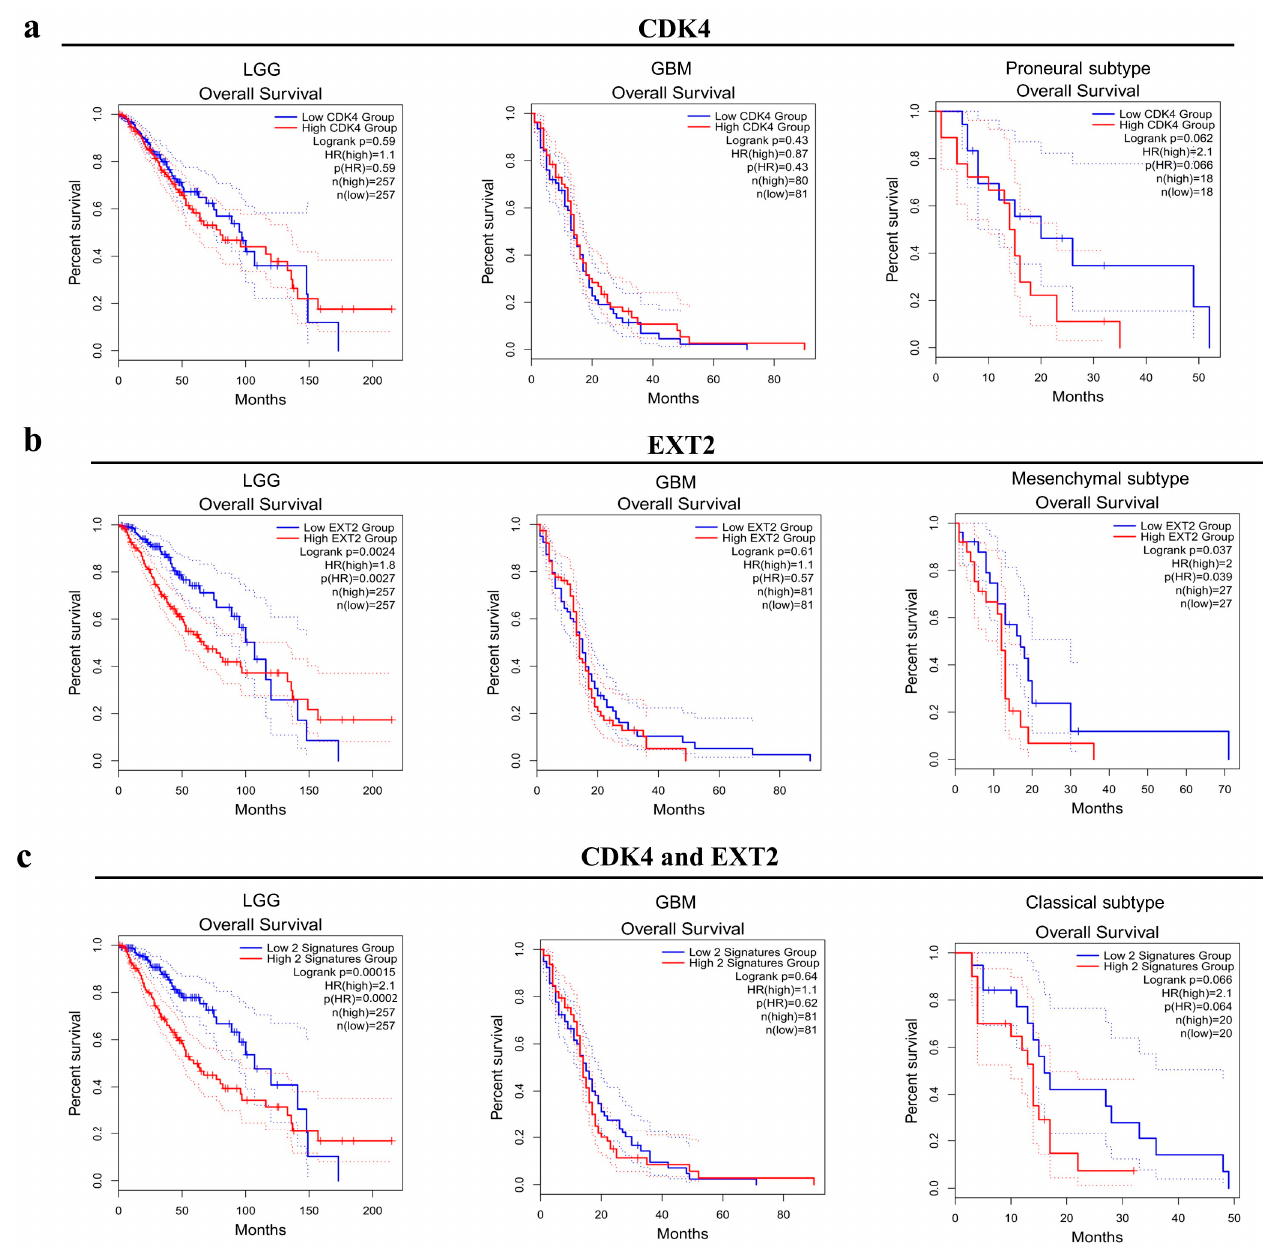
Figure 5. Kaplan–Meier curves of the overall survival of low-grade glioma (LGG) and glioblastoma (GBM) TCGA cohorts by CDK4 alone ( a ), EXT2 alone ( b ), CDK4 and EXT2 ( c ) mRNA expression, via GEPIA2. In blue, survival curves of patients with a low expression of the target gene(s); in red, survival curves of patients with a high expression of the target gene(s). Timing is expressed in months. Log-rank p values, hazard ratio (HR), HR p values, and the number of participants (n) of each group are reported.